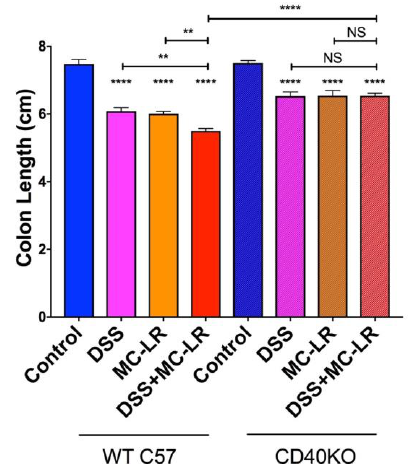
Figure 3. Effect of dextran sulfate sodium (DSS) and microcystin-leucine arginine (MC-LR) on colon length. Data presented indicate the mean ± SEM ( n = 6–11 mice per group). ** p < 0.01 and **** p < 0.0001.